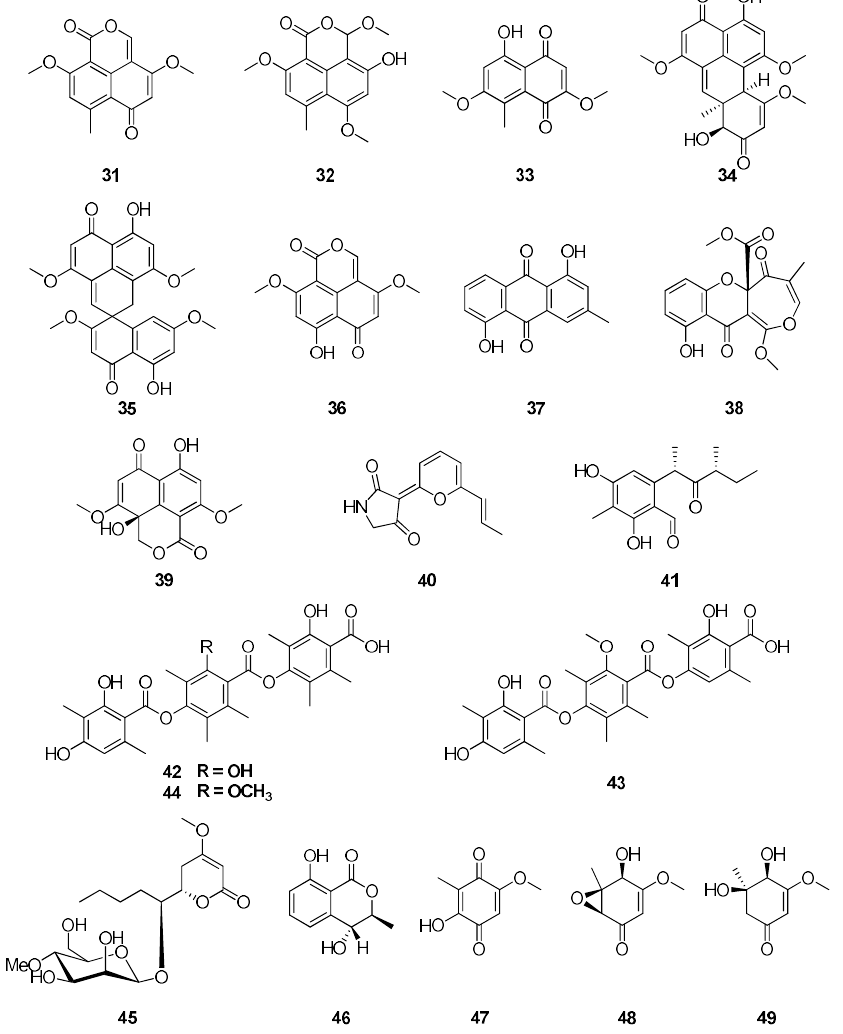
Figure 6. Compounds extracted from endophytic fungus Sporormiella minimoides obtained from Hintonia